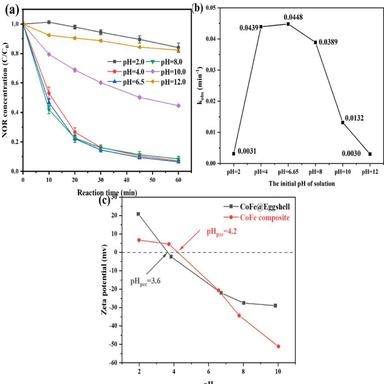
The effect of initial pH on NOR degradation by CoFe@Eggshell (a), the degradation rate in different pH (b), the Zeta potential of CoFe@Eggshell and CoFe composite (c). (General condition: = 10 mg/L, PMS = 0.4 g/L, catalyst = 0.3 g/L, without adjusting the initial pH, T = 25±0.1◦C. The error bars represent results of three duplicates.).